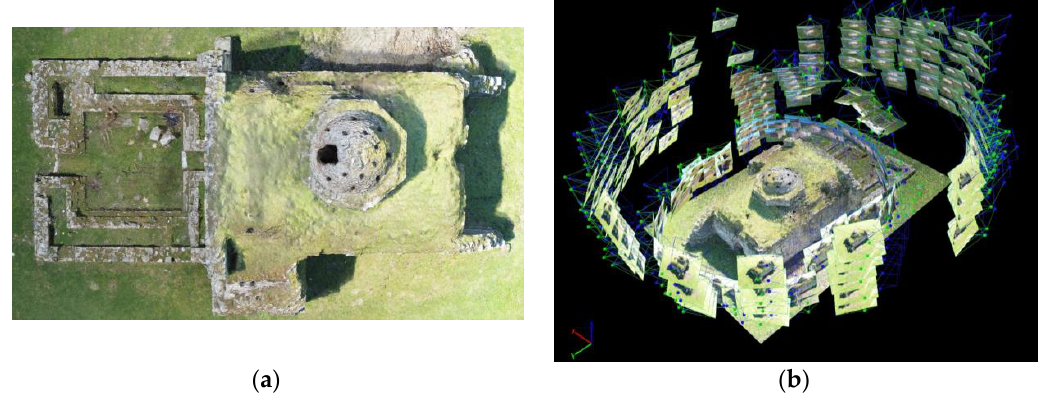
Figure 4. ( a ) An aerial photo of the bath; ( b ) photogrammetric mapping of the bath.